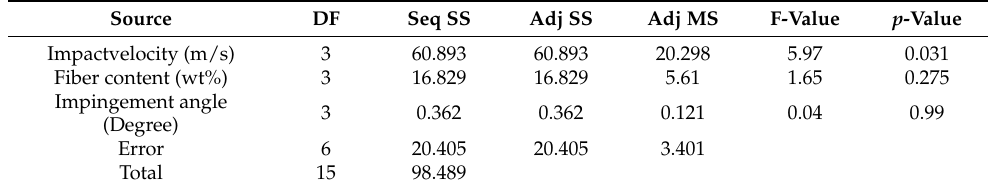
Table 9. Analysis of Variance for SNRA2, using adjusted SS for tests vinylester based